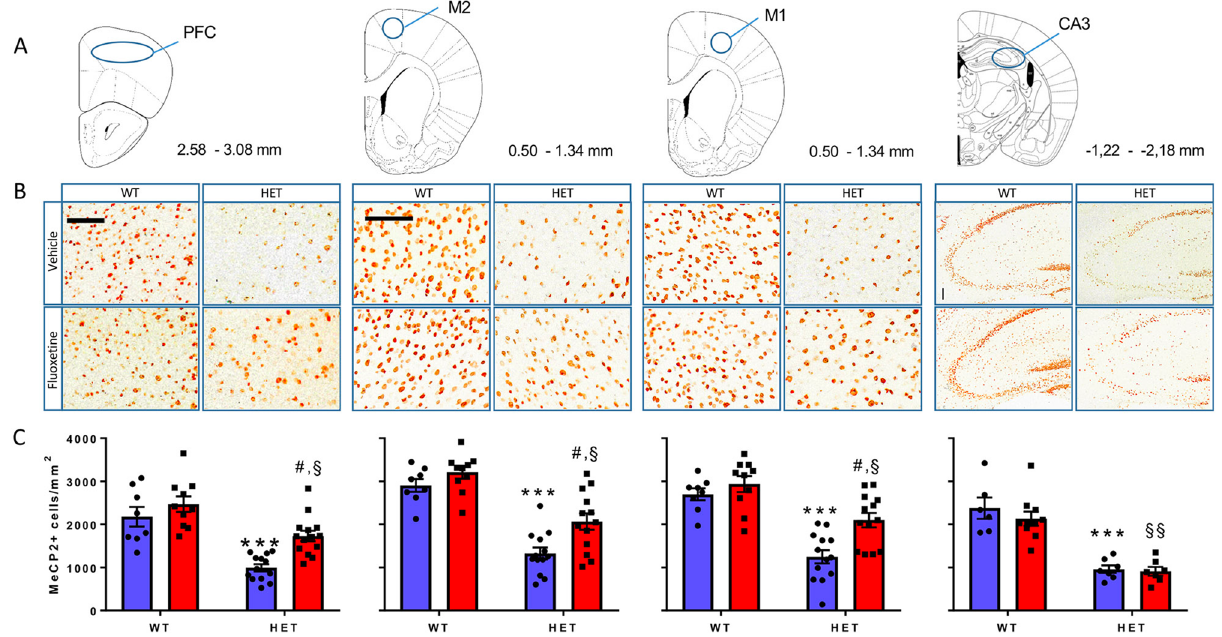
Figure 1. Effect of FLX on the number of MeCP2 + cells in the prefrontal cortex (PFC), M2, M1 and CA3. ( A ) Diagrams modified from the Franklin and Paxinos atlas 22 (with permission) showing pre-defined areas of the mouse brain in which MeCP2 + cells were counted. Numbers beside the diagrams indicate the antero- posterior range of the atlas in which slices were collected. ( B ) Enlargements of the original pictures obtained by the VS120 microscope showing MeCP2 + cells (brown dots) in representative sections of the PFC, M1 and M2 motor cortices and CA3 of WT and Mecp2 HET (HET) mice treated with 10 mg/kg FLX or vehicle for 14 days. On day 15 mice were euthanised and their brain processed for MeCP2 immunohistochemistry. Scale bars, 100 µm. ( C ) Histograms, generated with the Prism software (version 7.02; URL link), show the mean number (± SEM) of MeCP2 + cells in the PFC, M1 and M2 and CA3 of WT and HET mice (6–14 mice/group). Black dots and squares indicate individual data points. Blue and red columns indicate treatment with vehicle and FLX, respectively. *** P < 0.001 versus WT-H2O; # P < 0.01 versus HET-H2O; § P < 0.002, §§ P < 0.0001 versus WT-FLX (Sidak’s